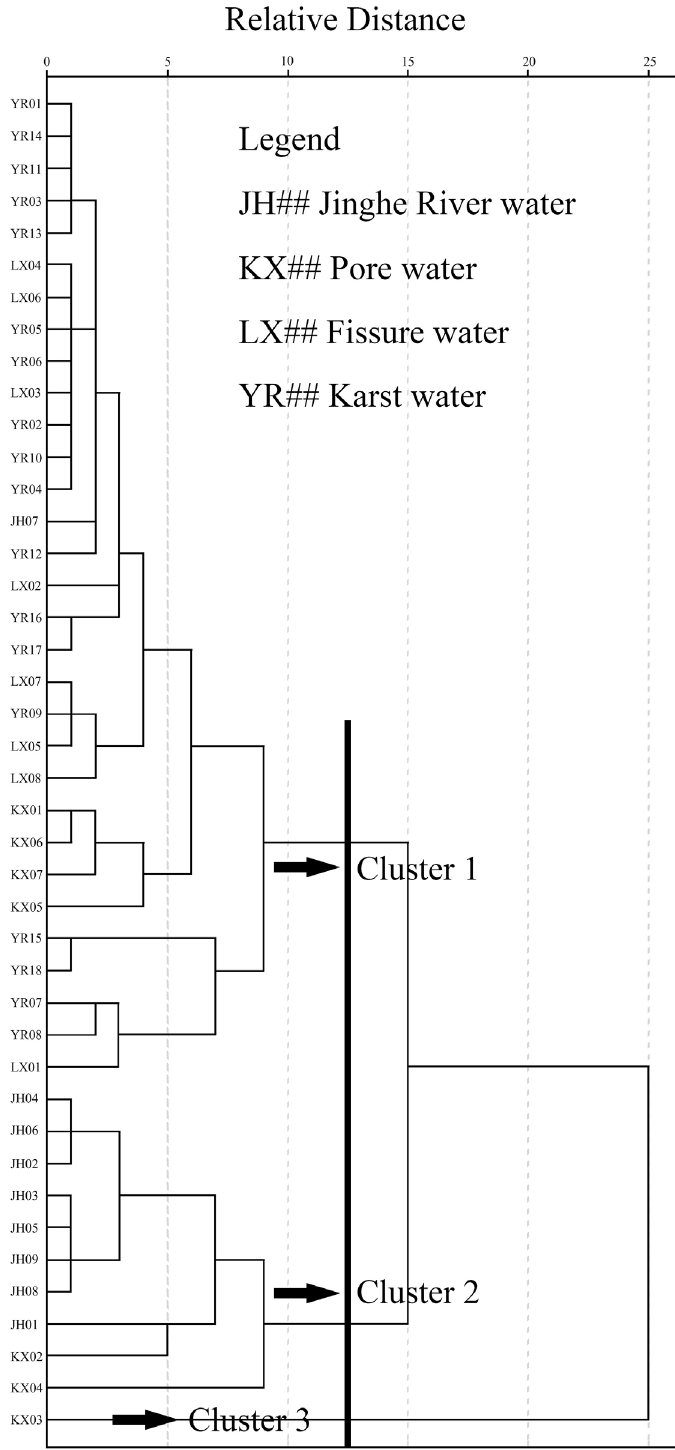
Figure 5. Clustering tree of water samples in the study area.